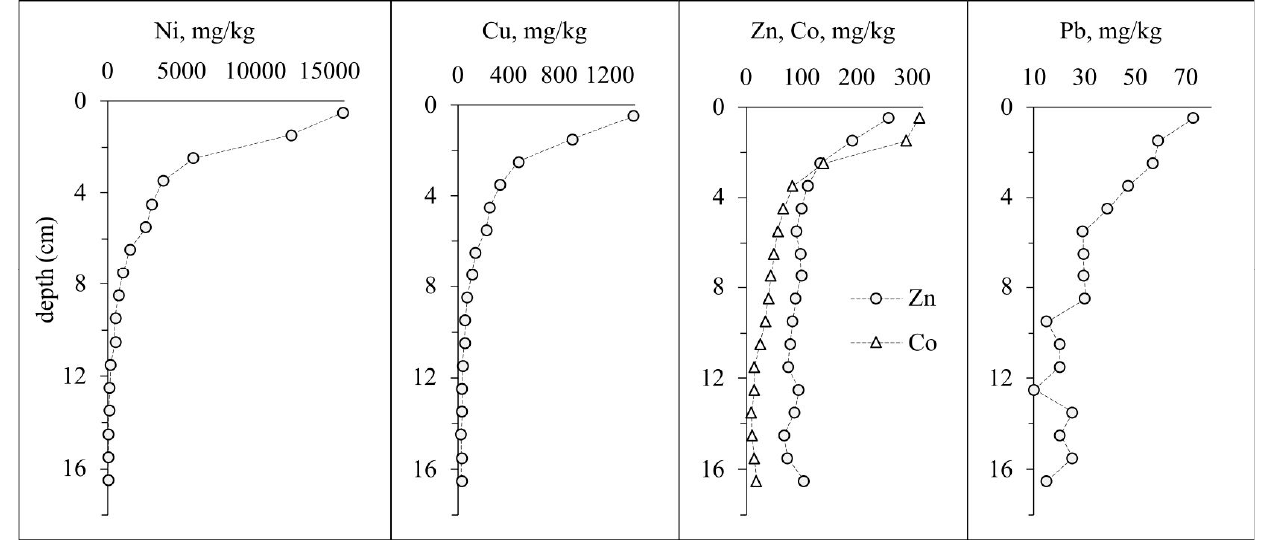
Figure 8. The vertical distribution of heavy metals in sediments of Lake Imandra (Murmansk Region) [35].